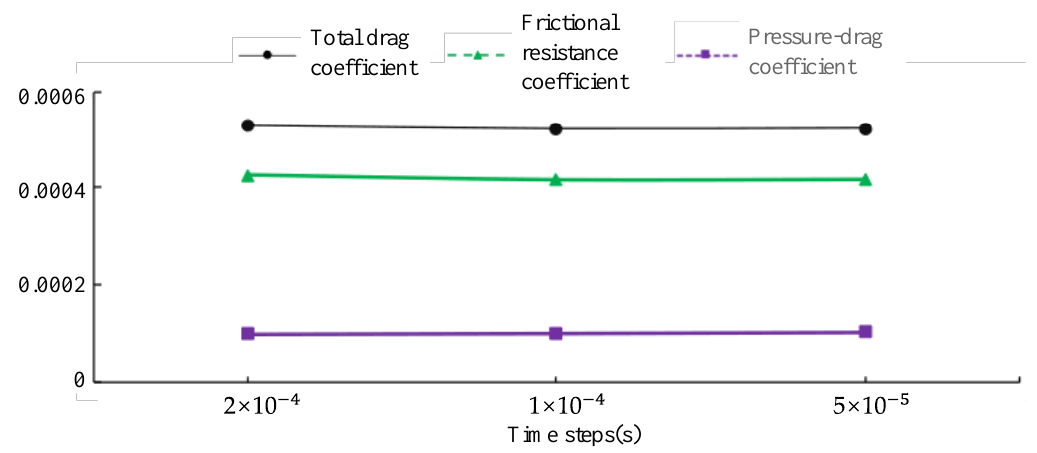
Figure 5. Verification results of time step independence.